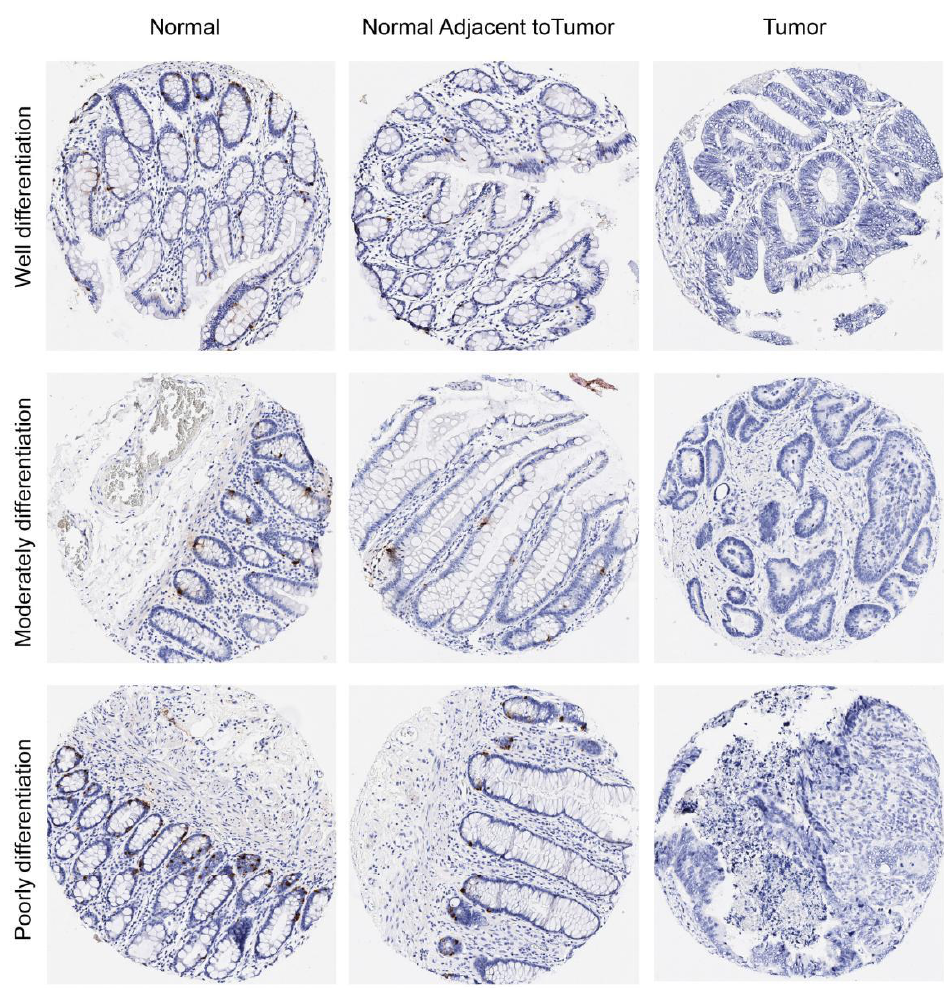
Figure 5. Protein expression of CHGA in normal mucosa, normal adjacent mucosa, and tumor from the same patient with colon cancer. The CHGA protein was positively expressed in the normal, and adjacent mucosa (the brown colour) and absolutely lost the CHGA expression in the tumor regardless of well-, moderately-, or poorly-differentiated cancers. Magnifications 10× and 40×. 6A: colon cancer patients, Figure 6D: rectal cancer patients, Figure 6G: CRC patients), diagnostic ROC tests (Figure 6B: colon cancer patients, Figure 6E: rectal cancer patients, Figure 6H: CRC patients), and survival tests (Figure 6C: colon cancer patients, Figure 6F: rectal cancer patients, Figure 6I: CRC patients). CHGA showed significantly lower expression in CRC patients than normal controls and behaved well in the diagnostic test (AUC: 0.995). However, CHGA may not be served as a prognostic biomarker for CRC patients ( p -values on survival test: 0.24, 0.38, and 0.13, respectively).